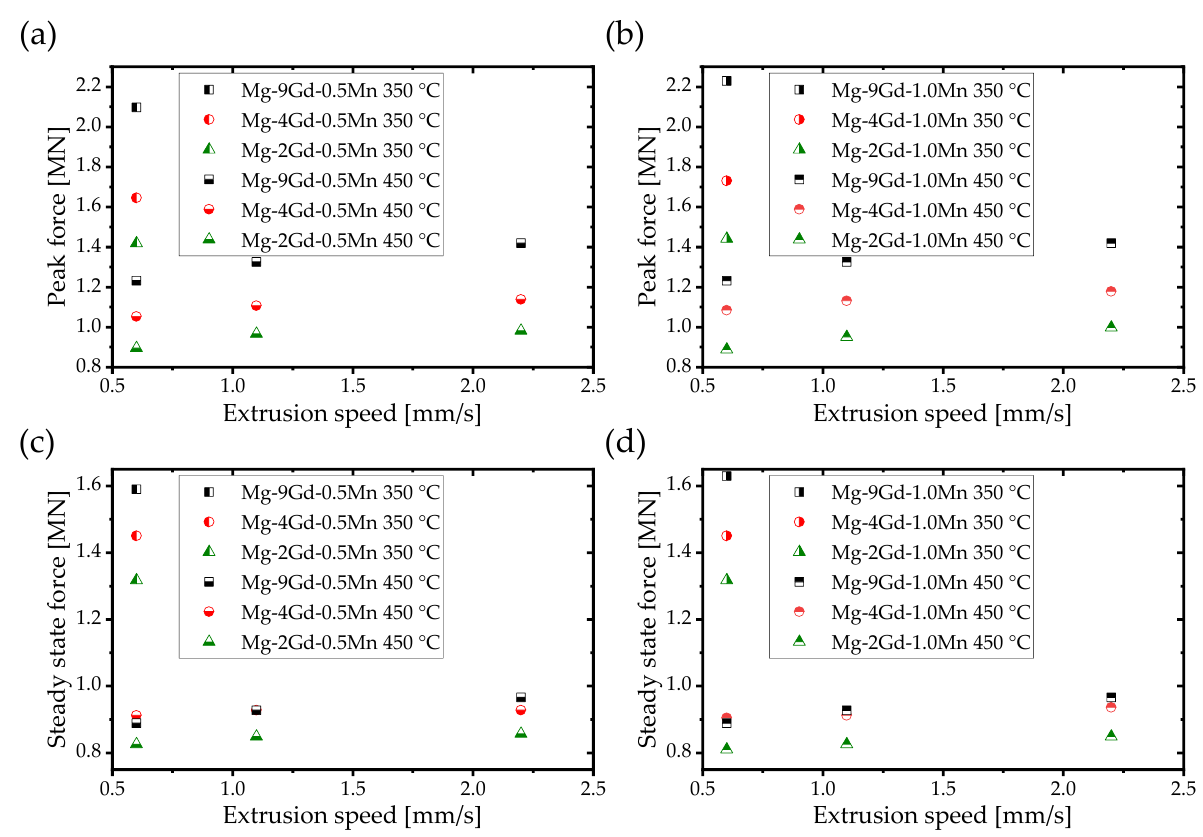
Figure 1. Extrusion forces peak force for Mg-xGd-0.5Mn ( a ) and for Mg-xGd-0.5Mn ( b ) and steady state force for Mg-xGd-0.5Mn ( c ) and for Mg-xGd-0.5Mn ( d ) with respect to extrusion parameters.